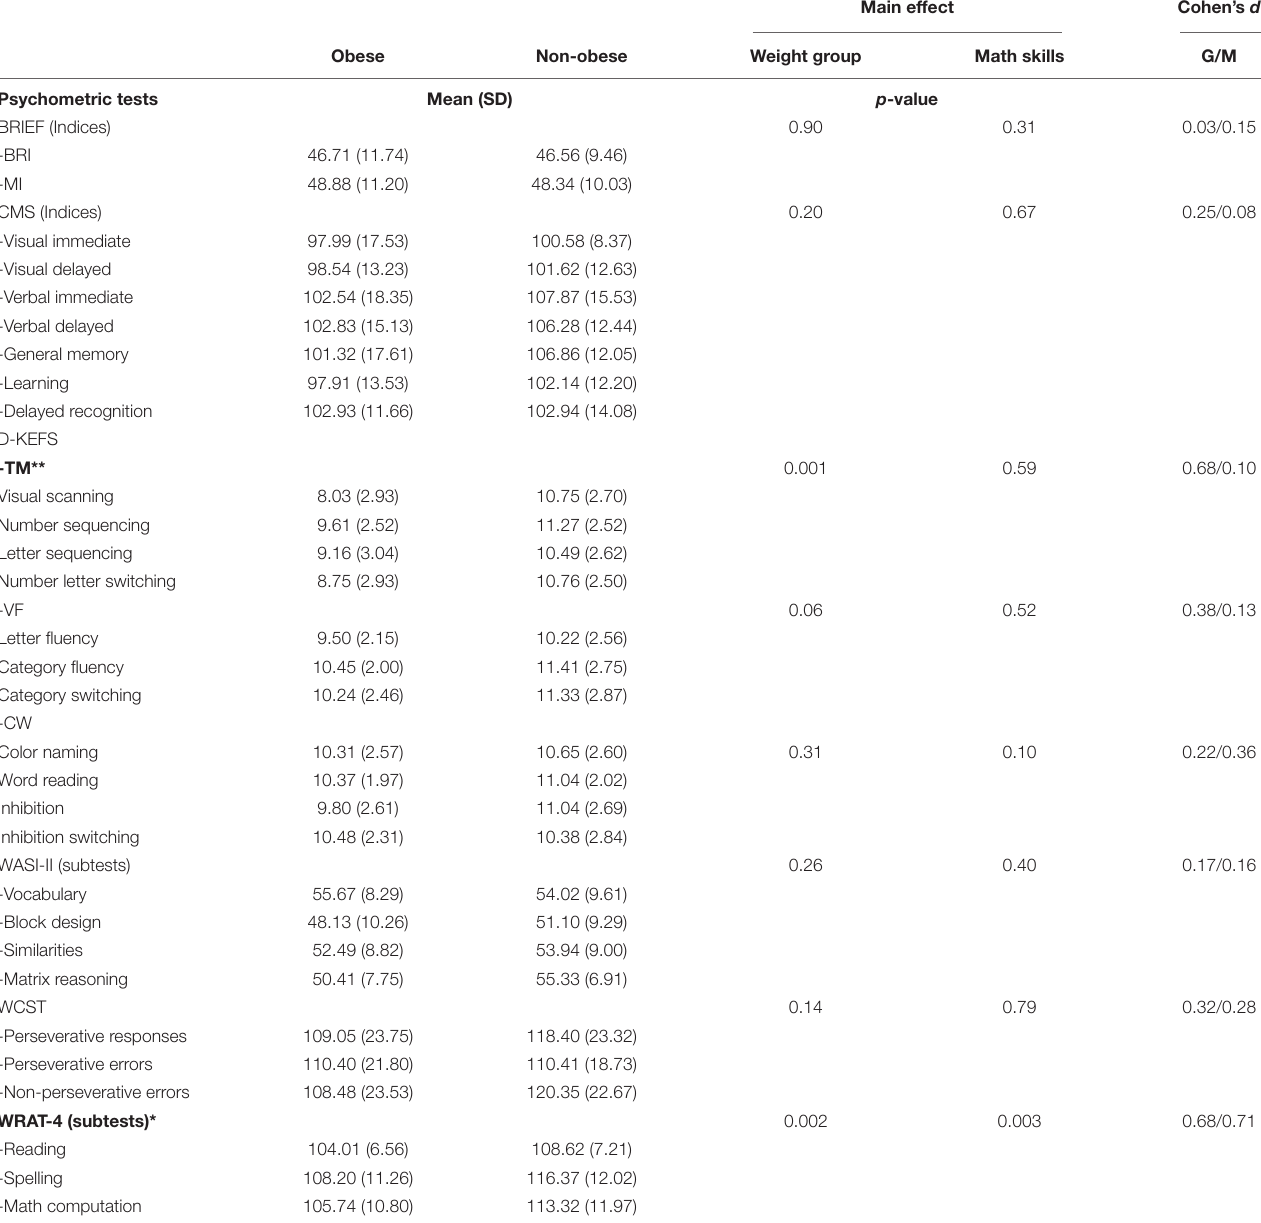
TABLE 4 | Psychometric assessment of